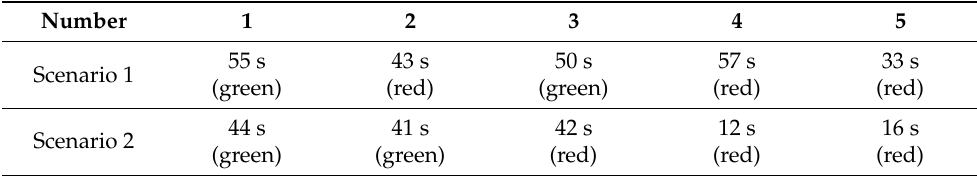
Table 3. Initial color and remaining time of each traffic light in the two